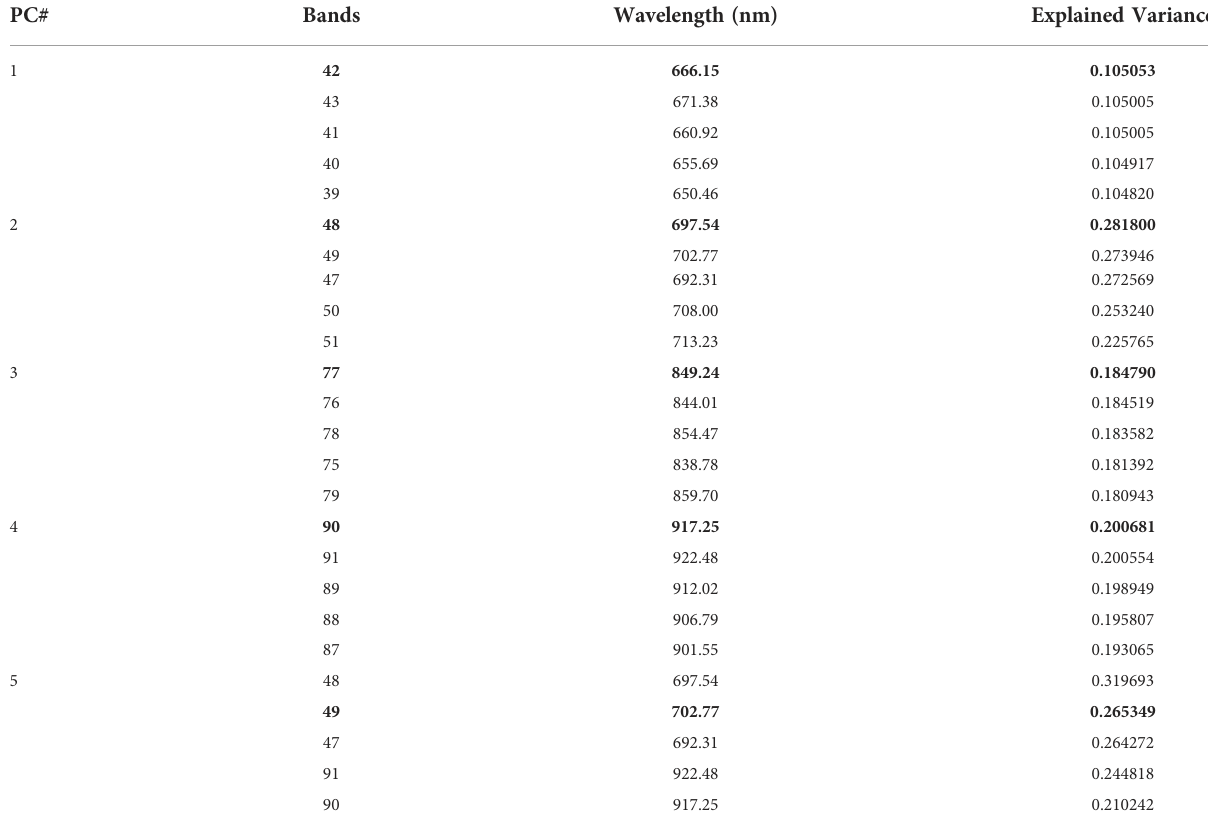
Bold values refer to the most contributing wavelengths for each PC